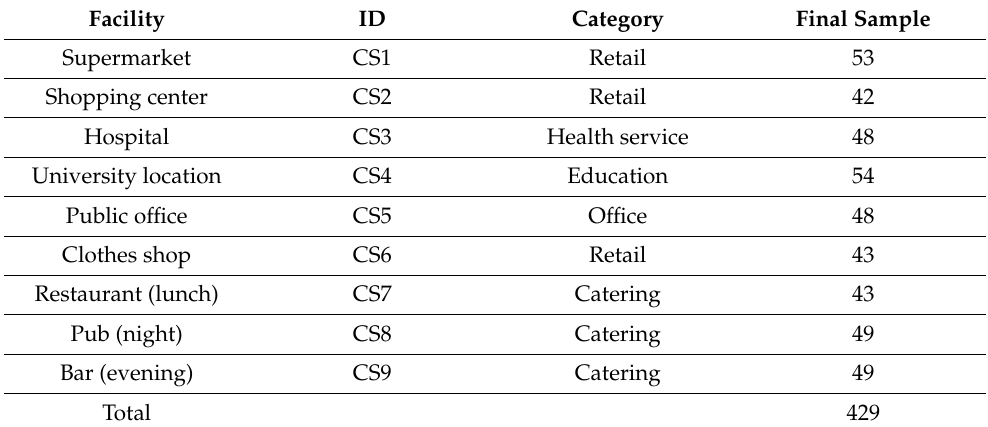
Table 5. Facilities involved in the case study interviews and related number of